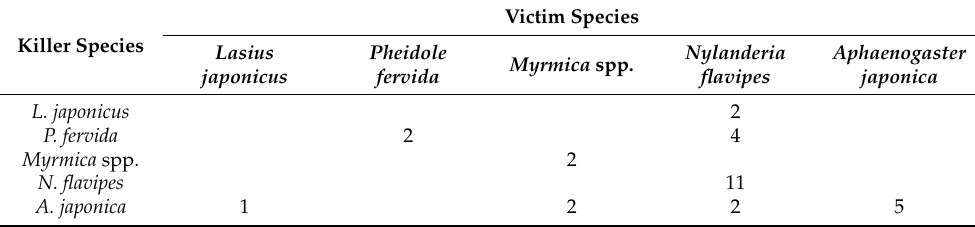
Table 5. Number of killed ants carried by other